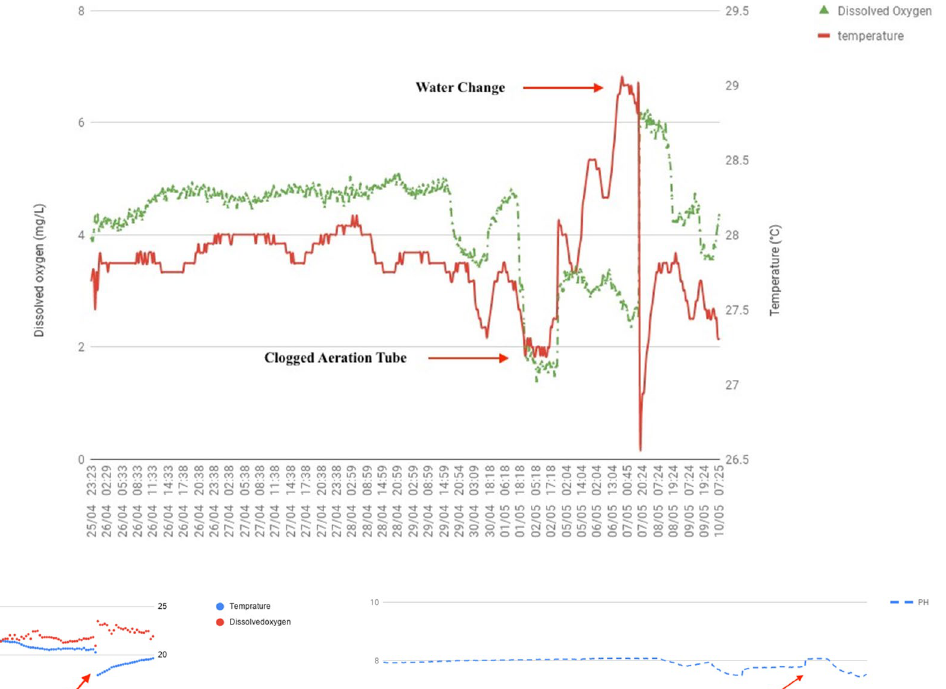
Fig. 10 Temperature and dis- solved oxygen data from multi- sensor node while monitoring the Tilapia experiment